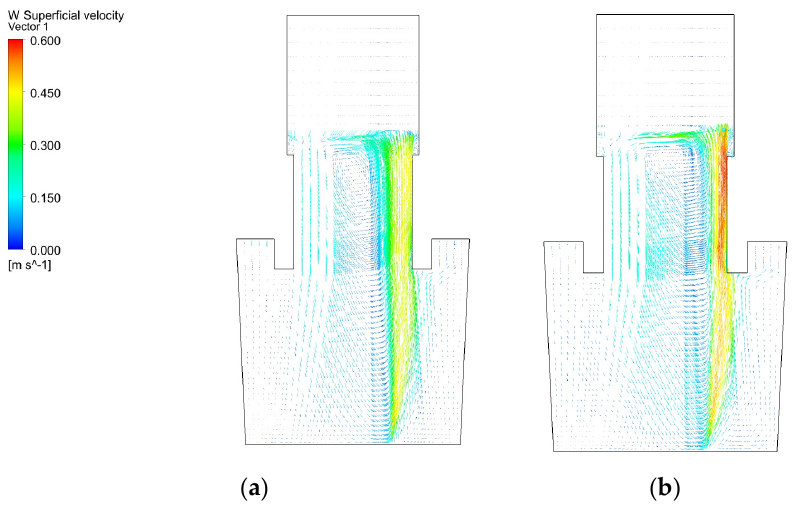
Figure 3. Superficial velocity vector diagram at Z = 0 plane with a flow rate of 900 NL/h: ( a ) With PBM; ( b ) Without PBM.